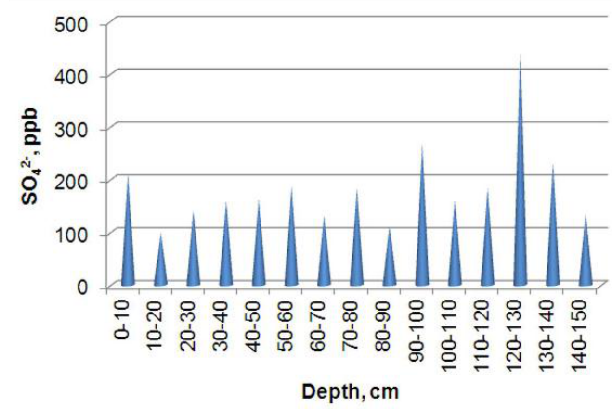
Fig. 2. The nss-SO 2 − concentrations in the 1276km snow pit. 4